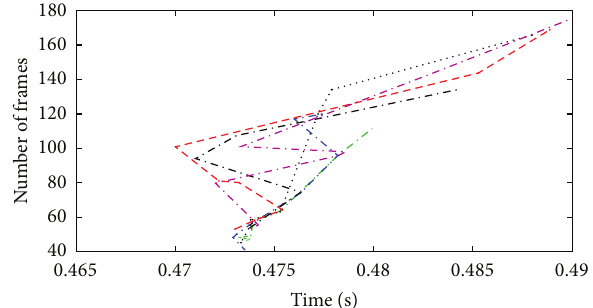
Figure 9: An analysis of number of frames required to identify an action.